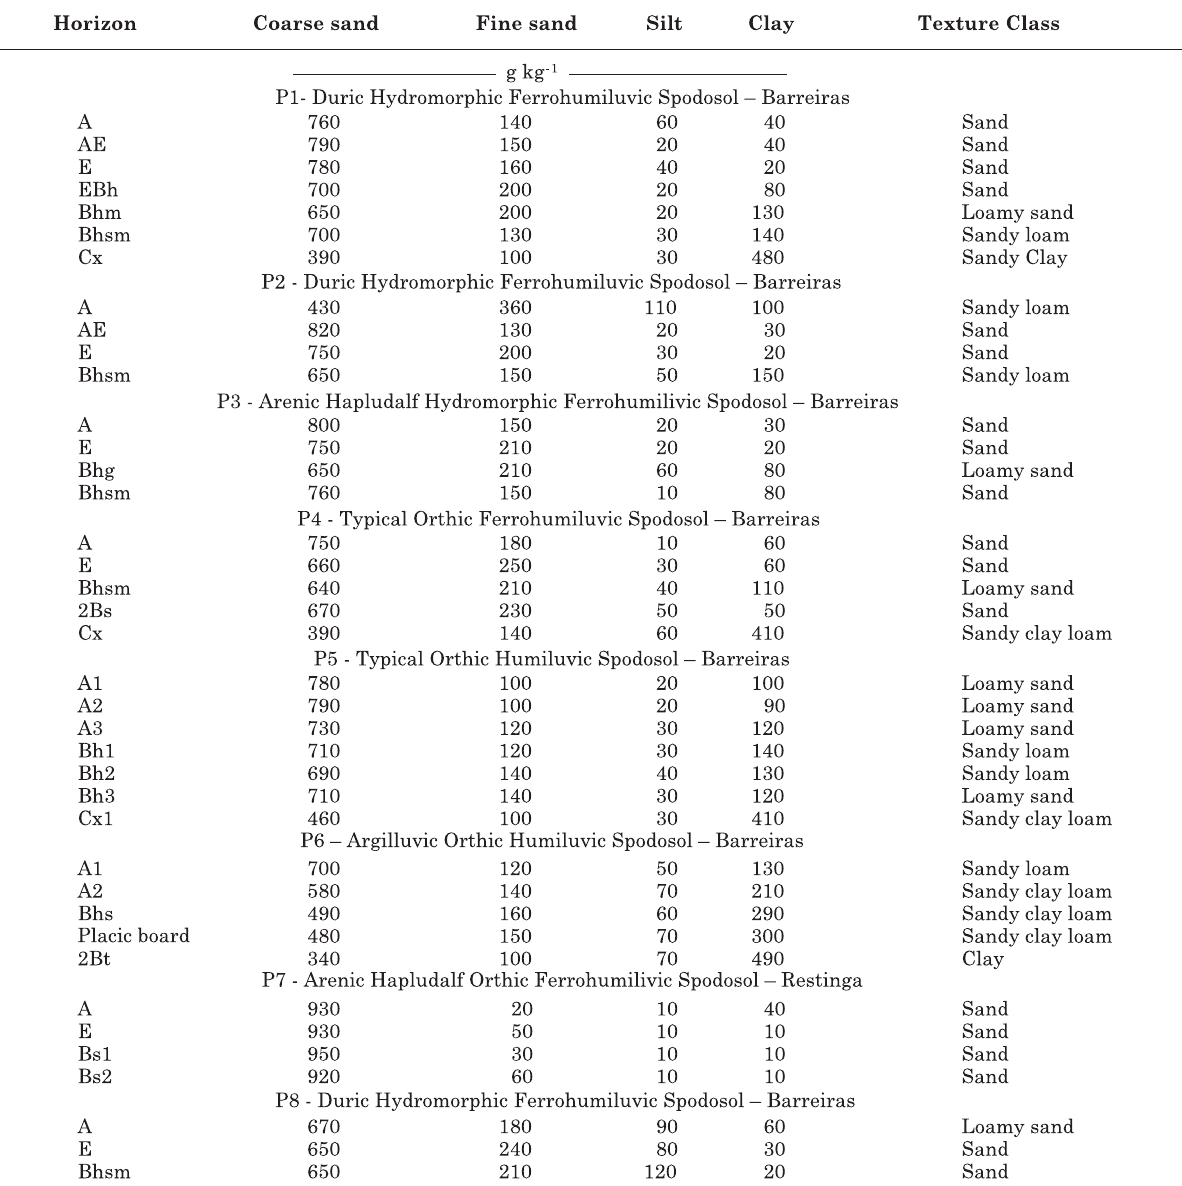
Table 2. Physical properties of soil